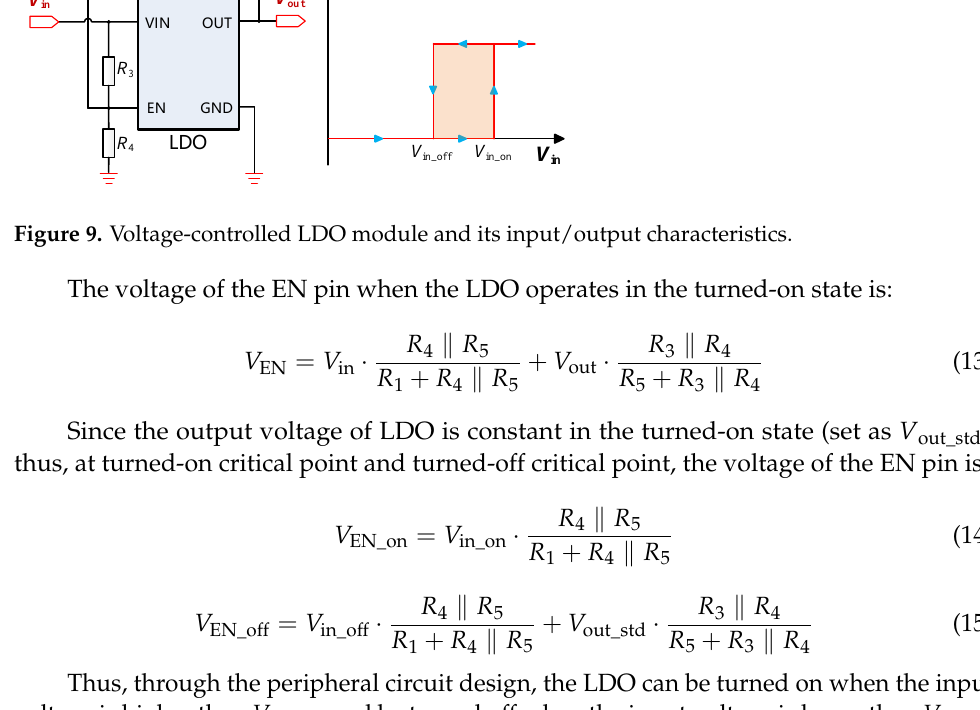
(13) Since the output voltage of LDO is constant in the turned-on state (set as V out_std ), thus,